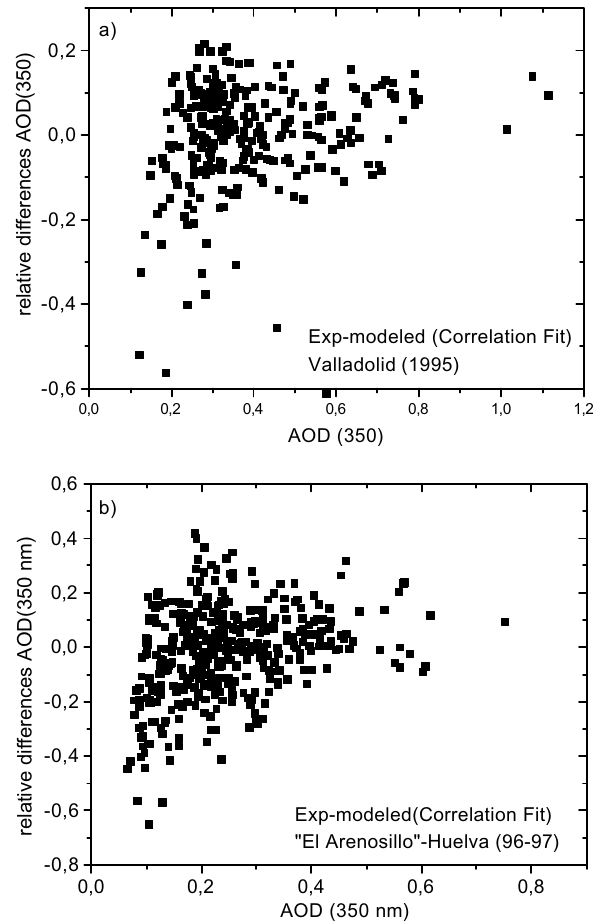
Fig. 6. Relative differences between the experimental AOD at 350nm and the AOD values retrieved from the polynomial expres- sion as a function of the experimental AOD values at 350nm: (a) for the data of the north central station of Valladolid; (b) for the data of the southwest station of “El